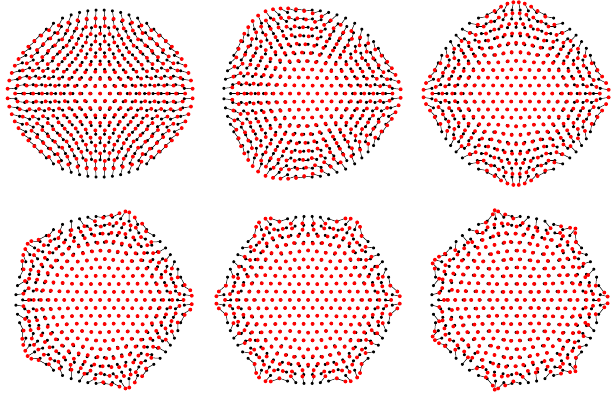
Figure 1: Anti-holomorphic modes z n , 1 ≤ n ≤ 6, found numerically for a steadily rotating vortex crystal, N = 331. Equilibrium vortex positions given by black points, displacement under the anti-holomorphic mode given by red